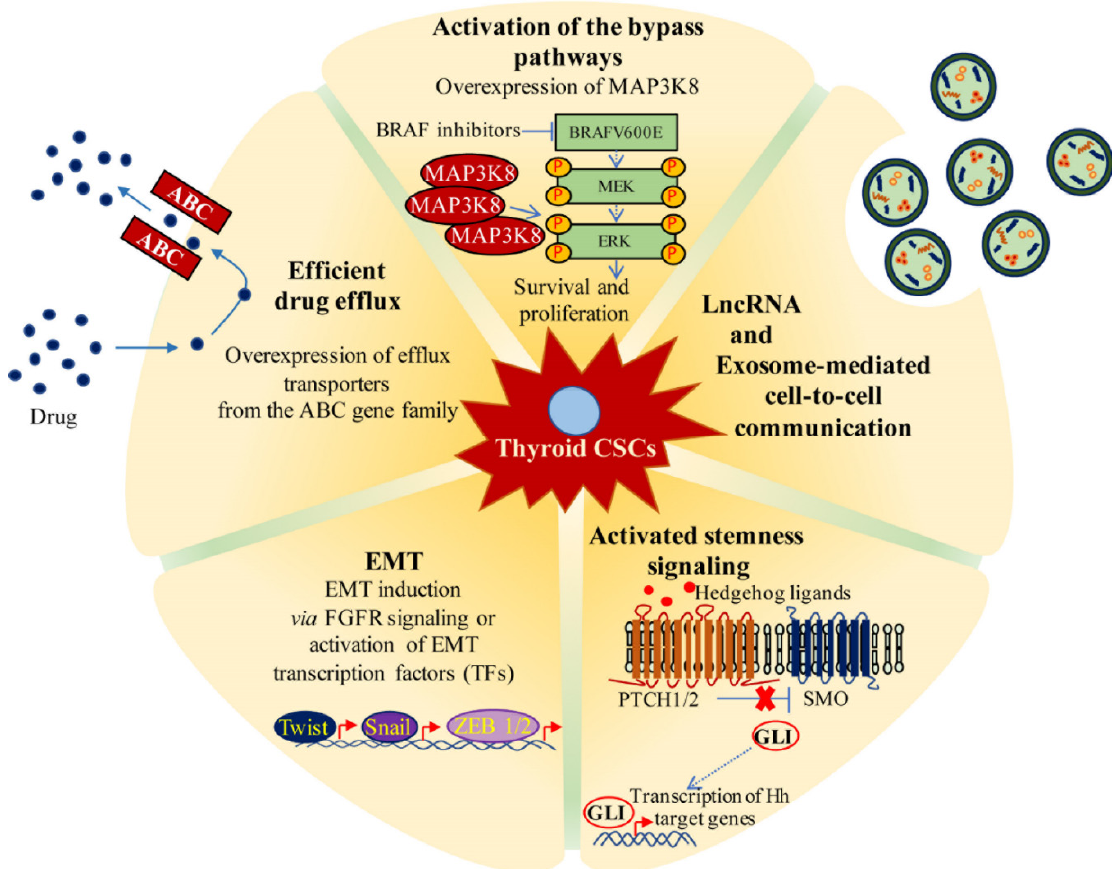
Figure 4. Molecular mechanisms underlying thyroid cancer stem cells (CSCs) resistance to therapy with kinase inhibitor. Resistance of CSCs to kinase inhibitor (KI) may be caused by different mechanisms, including epithelial-to-mesenchymal transition, increased drug efflux efficiency, activation of the bypass pathways, lncRNA and exosomes mediated cell-cell communication and deregulation of the stem cell signaling pathways. Abbreviations: MAP3K8 = Mitogen-Activated Protein Kinase Kinase 8, BRAF = v-raf murine sarcoma viral oncogene homolog B1, BRAFV600E = valine-to-glutamic acid substitution at amino acid residue 600 of BRAF protein, MEK = Mitogen-Activated Protein Kinase Kinase, ERK = Extracellular Signal-Regulated Kinase, LncRNA = Long non-coding RNA, PTCH1/2 = Patched1 and 2, SMO = Smoothened, GLI = glioma-associated oncogene family zinc finger, Twist = Twist-related protein 1, Snail = zinc finger protein SNAI1, ZEB 1 / 2 = Zinc finger E-box binding protein 1 and 2, TF = transcription factor, EMT = epithelial-mesenchymal transition, FGFR = fibroblast growth factor receptor.